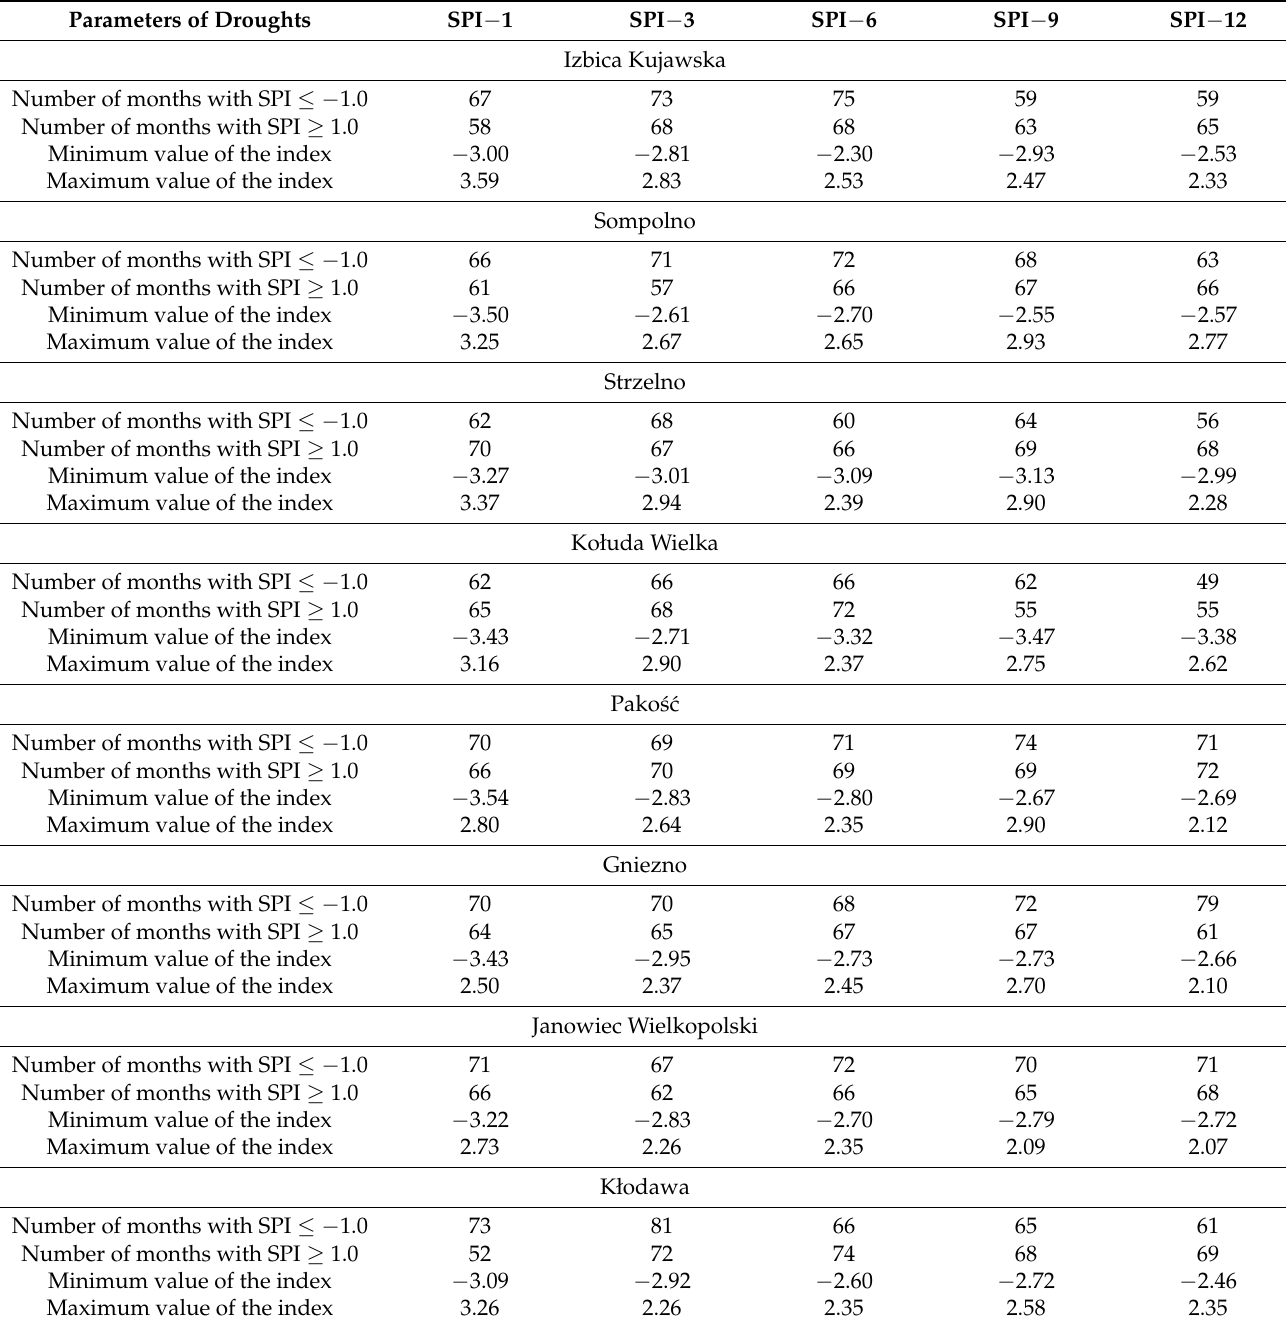
Table 4. Meteorological drought parameters (SPI) in different time scales in the period of 1981–2016. Parameters of Droughts SPI − 1 SPI − 3 SPI − 6 SPI − 9 SPI − 12 Izbica Kujawska Number of months with SPI ≤ −